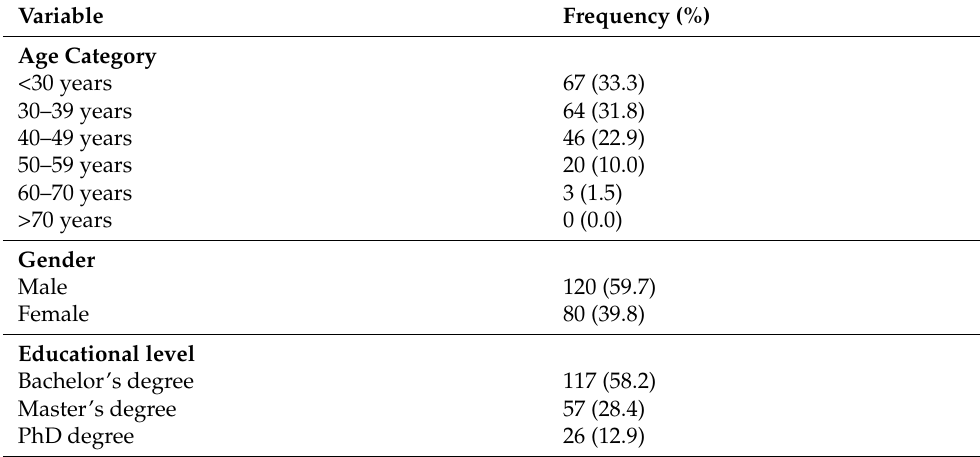
Table 1. Characteristics of the participants (n =